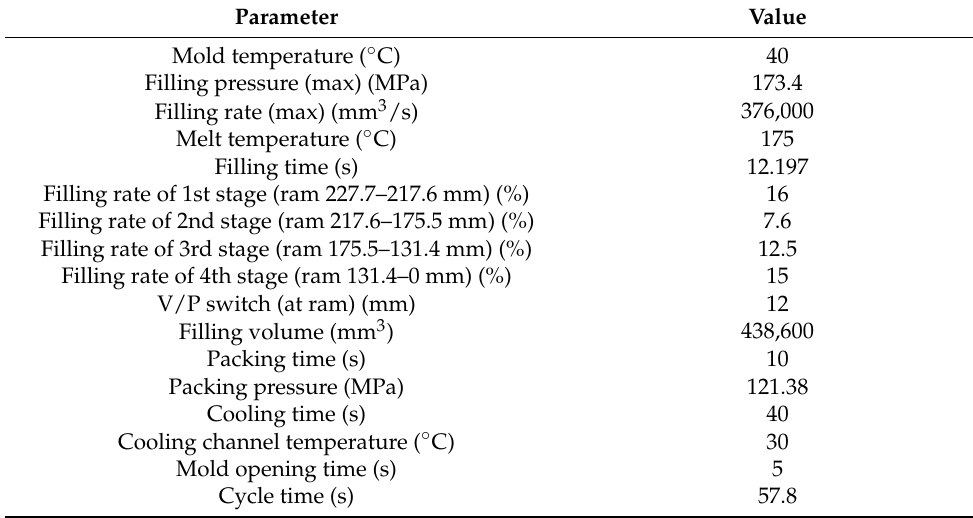
Figure 2. Injection-molded PVC elbows: ( a ) isometric view of the twelve fittings and runners; ( b ) top view of the twelve fittings and runners (302 mm × 200 mm × 60 mm); ( c ) bottom view of the twelve fittings and runners; ( d ) isometric view of the cooling channel within the core plate; ( e ) isometric view of the cooling channel within the cavity plate. Table 1. Initial injection molding parameters of Suspension S-60 PVC for